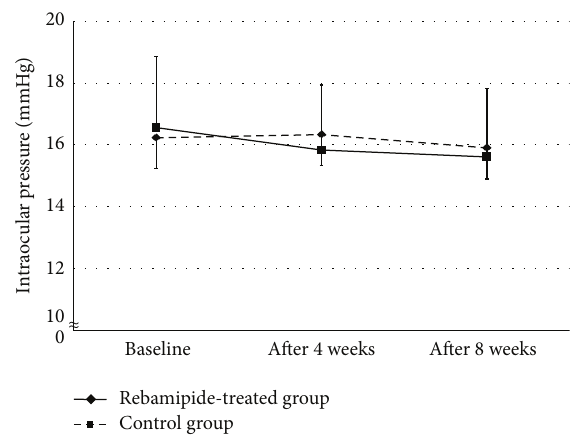
Figure 1: Changes in intraocular pressure in the rebamipide- treated group and control group. Both groups maintained reduced intraocular pressurewithout significant difference during